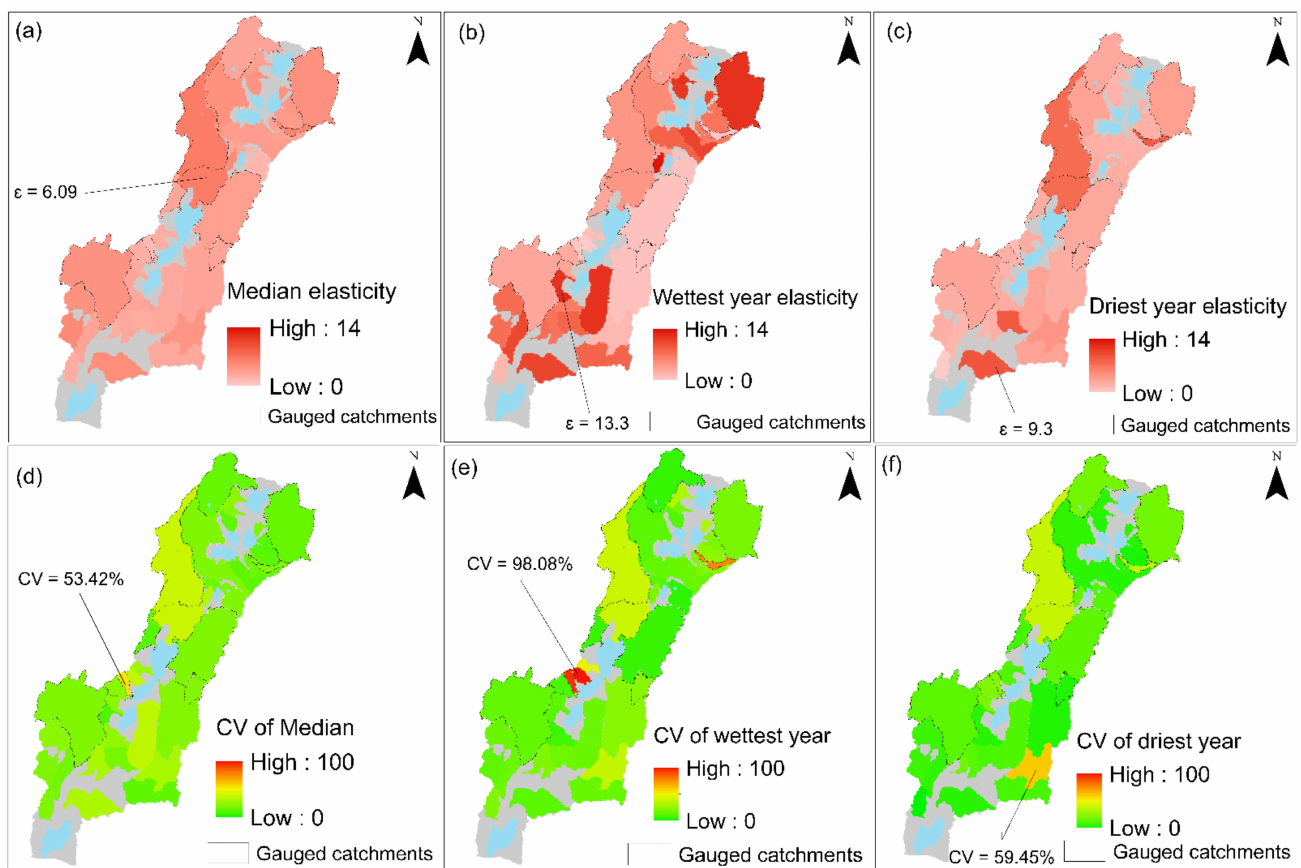
Figure 8. ( a – c ) Elasticity calculated for the median, wettest, and driest years for both gauged and ungauged catchments and ( d – f ) their corresponding simulation uncertainty expressed by the coefficient of variation